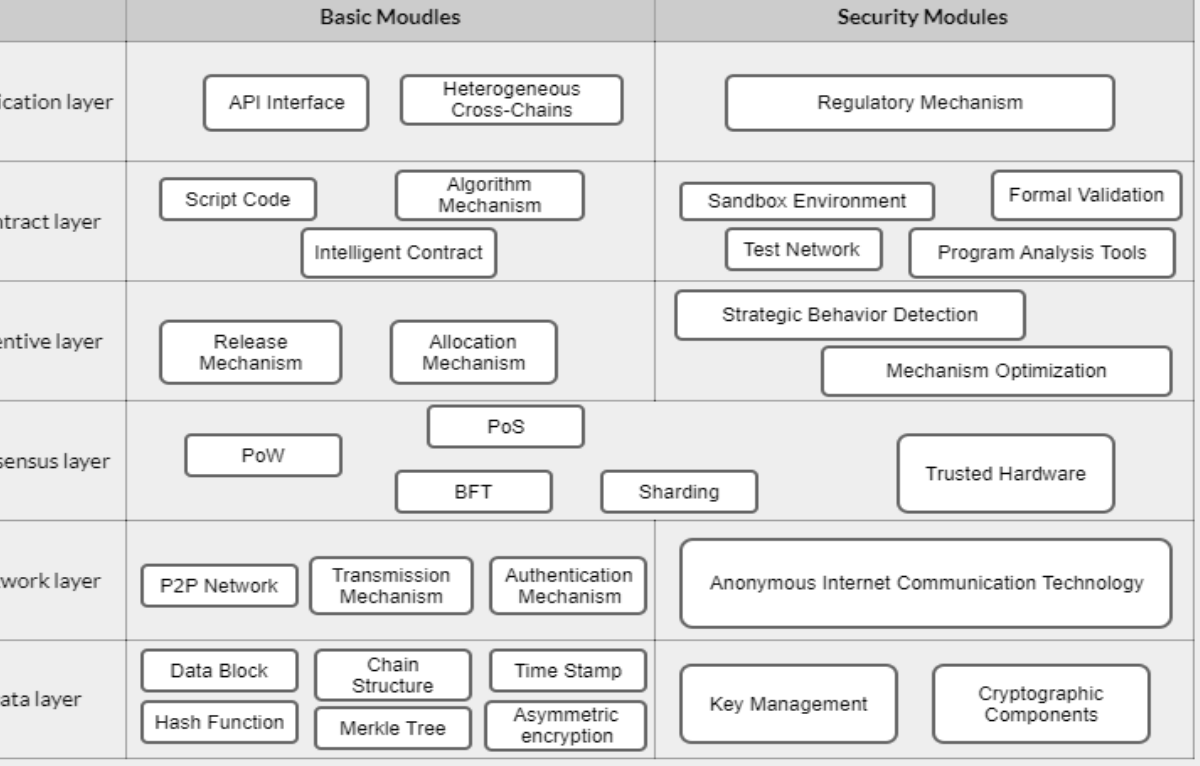
Figure 5. The blockchain system architecture.